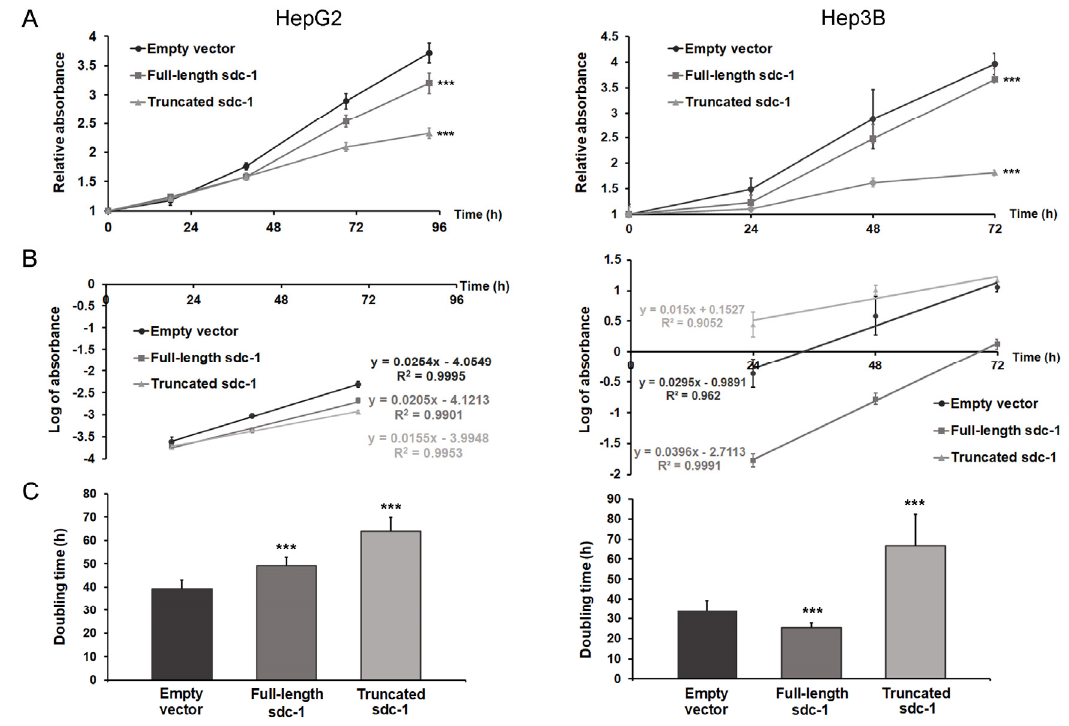
Figure 5. The effect of syndecan-1 overexpression on the proliferation of HepG2 and Hep3B cell lines. ( A ) Transfection with the truncated syndecan-1 construct significantly slowed down the proliferation of both HepG2 and Hep3B cell lines. A moderate decrease in the proliferation of HepG2 full-length transfectant was also observed. Notably, overexpression of full-length syndecan-1 in Hep3B cells led to a decrease in double time from 33.89 to 25.27 h (by 25.4%); ( B ) The log phase of growth curves; ( C ) Doubling time calculated from the log phase of growth curves. Data points represent the mean ± SD, n = 8; *** p < 0.001 versus the empty vector transfectant.